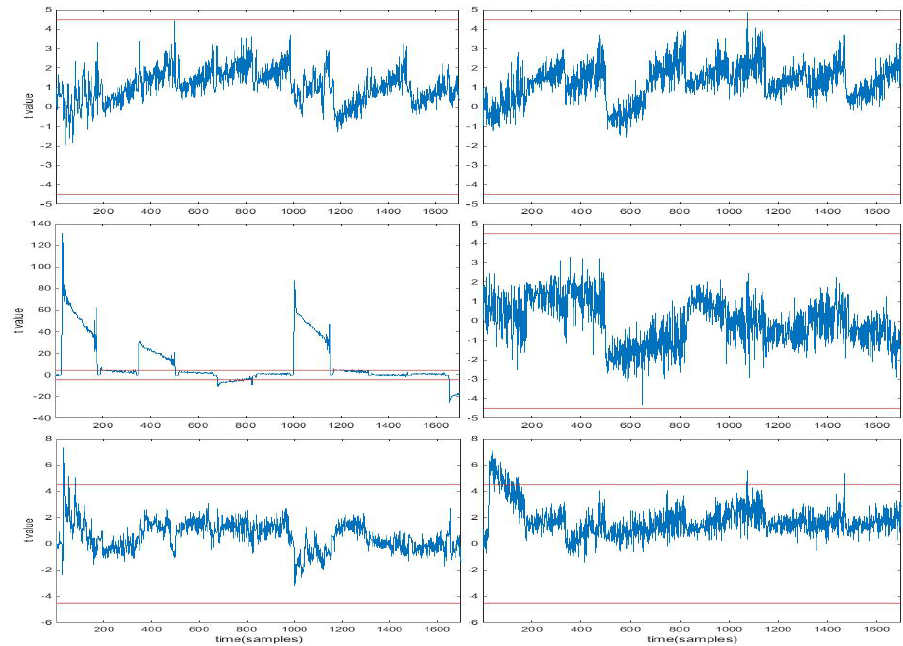
Figure 5: TVLA on our first (left) and second-order (right) NC- Keccak implementations over 55M traces. From top to bottom: first-, second-, and third-order analysis